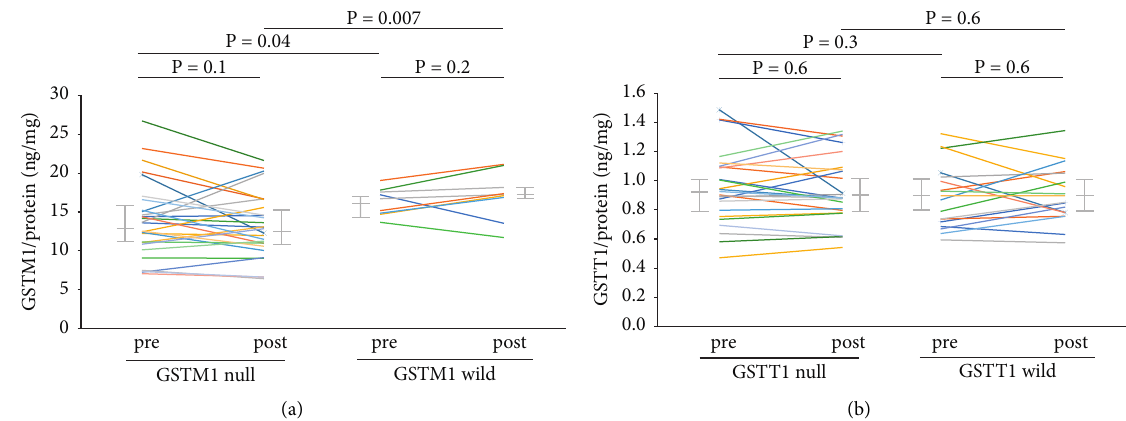
Figure 3: Plasma GSTM1 and GSTT1 protein levels according to genotype. The plasma GSTM1 protein concentrations before and after the TDI challenge in individuals with the null ( n � 31) or wild-type ( n � 12) GSTM1 genotype (a). The plasma GSTT1 protein concentrations before and after the TDI challenge in individuals with the null ( n � 25) or wild-type ( n � 18) GSTT1 genotypes